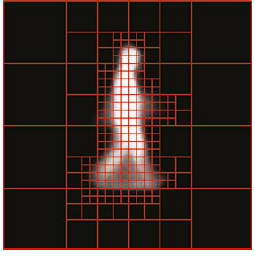
Figure 4: Quadtree decomposition results of a walking